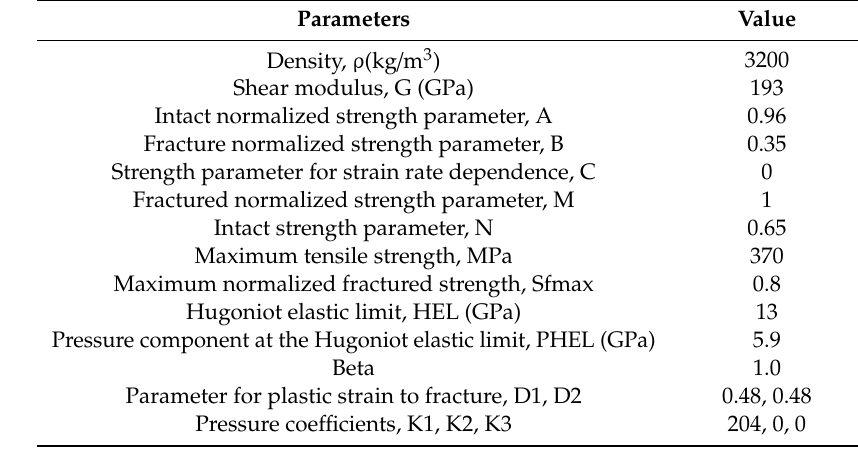
Table 2. JH-2 parameters for SiC.